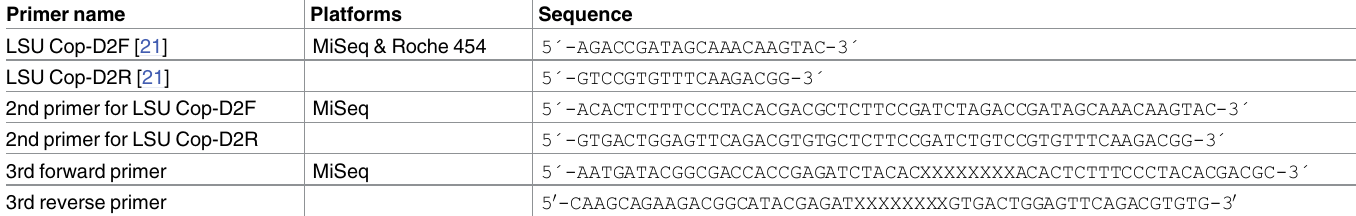
Table 1. PCR primers used in this